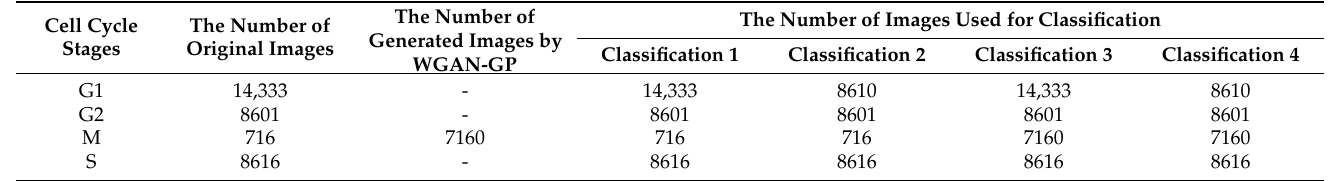
Table 2. The number of images of different cell cycle stages and the number of images used for four stages. Cell Cycle The Number of Stages Original